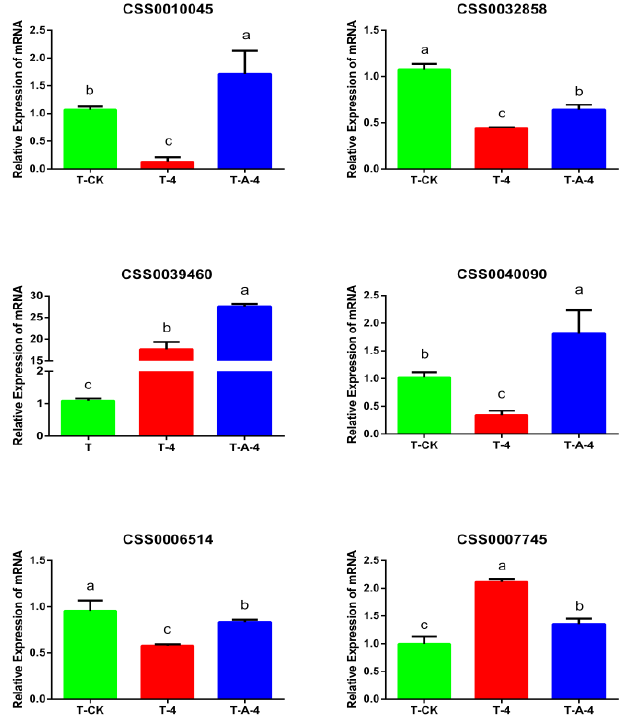
Figure 5. Verification of expression patterns of selected genes. Different lowercase letters of the same period indicate that there are significant differences be-tween different